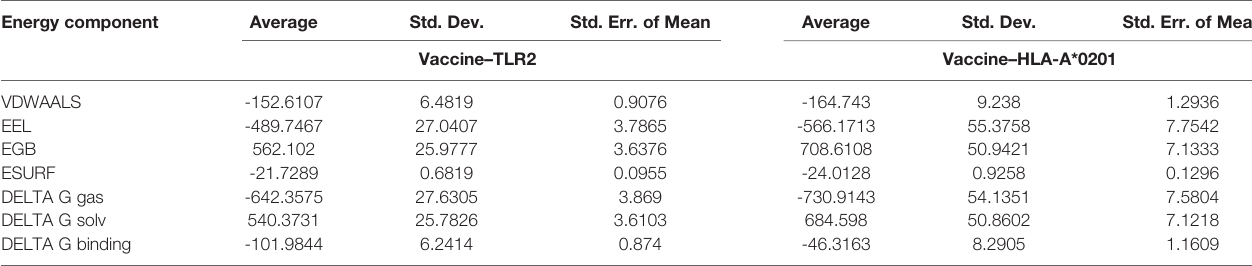
TABLE 6 | Energy analysis of the vaccine – TLR2 and vaccine – HLA-A*02:01 complexes in the molecular dynamics simulation. Energy component Average Std. Dev. Std. Err. of Mean Average Std.